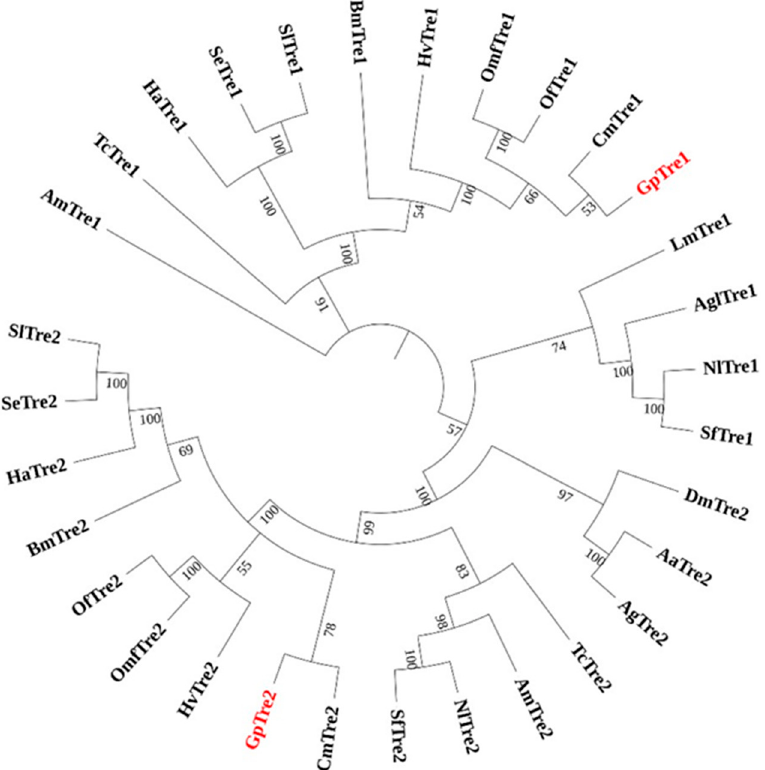
Figure 2. Phylogenetic analysis of trehalases in different species based on amino acid sequences. The evolutionary history was inferred using the neighbor-joining method with 1000 bootstraps, and next to the branches only percentages of replicate trees of above 50% are shown. Aedes aegypti (Aa), Anopheles gambiae (Ag), Aphis glycines (Agl), Apis mellifera (Am), Drosophila melanogaster (Dm), Bombyx mori (Bm), Locusta migratoria manilensis (Lm), Nilaparvata lugens (Nl), Omphisa fuscidentalis (Omf), Spodoptera exigua (Se), Sogatella furcifera (Sf), Tribolium castaneum (Tc), Helicoverpa armigera (Ha), Heortia vitessoides (Hv), Spodoptera litura (Sl), Cnaphalocrocis medinalis (Cm), Ostrinia furnacalis (Of).